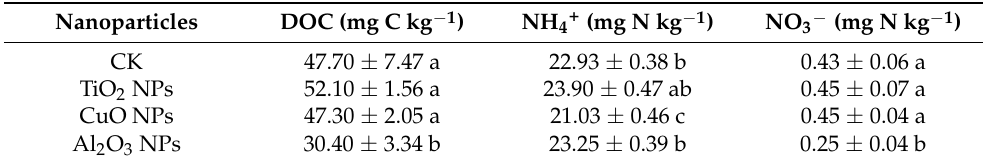
Table 2. Soil dissolved organic carbon (DOC), ammonium (NH 4+ ), and nitrate (NO 3 − ) contents in different nanoparticles